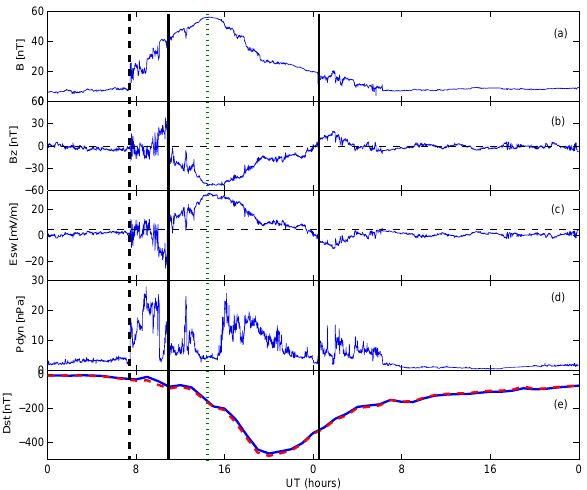
Fig. 11. Solar wind parameters and geomagnetic indices for a 2- day interval from 20–21 November 2003 measured by ACE. The figures from top to bottom are the same as in Fig. 9. The dashed line indicates the shock and two solid lines indicate the interval of the MC.